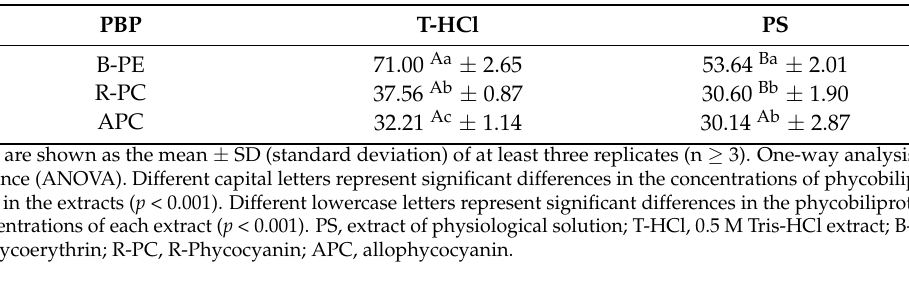
Table 4. Total chlorophylls and carotenoids in the methanolic extract of P. cruentum (mg · g − 1 PS). Pigment MetOH C